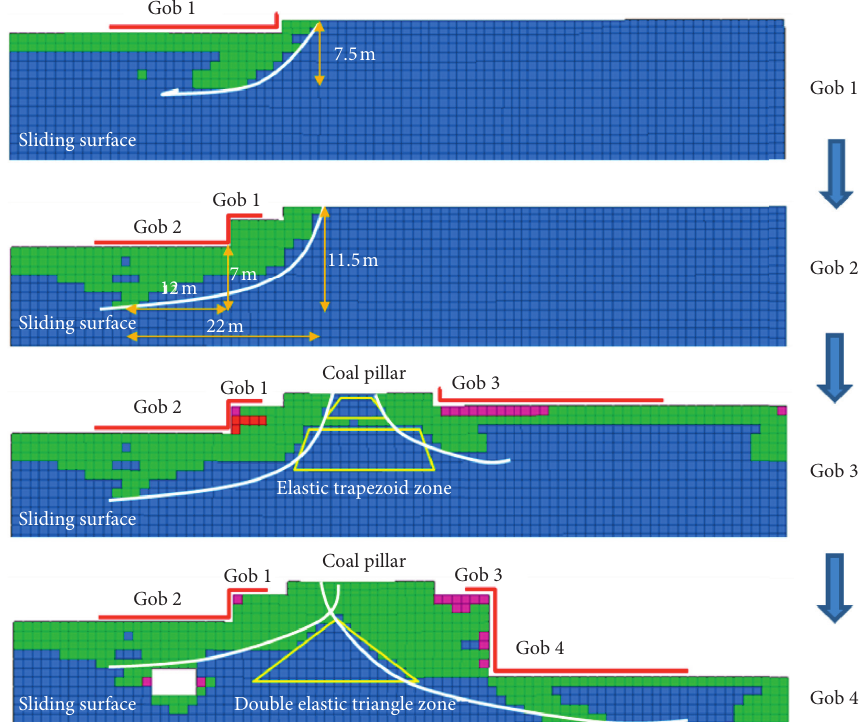
Figure 14: Distribution map of plastic zone under double gobs in close coal seams.